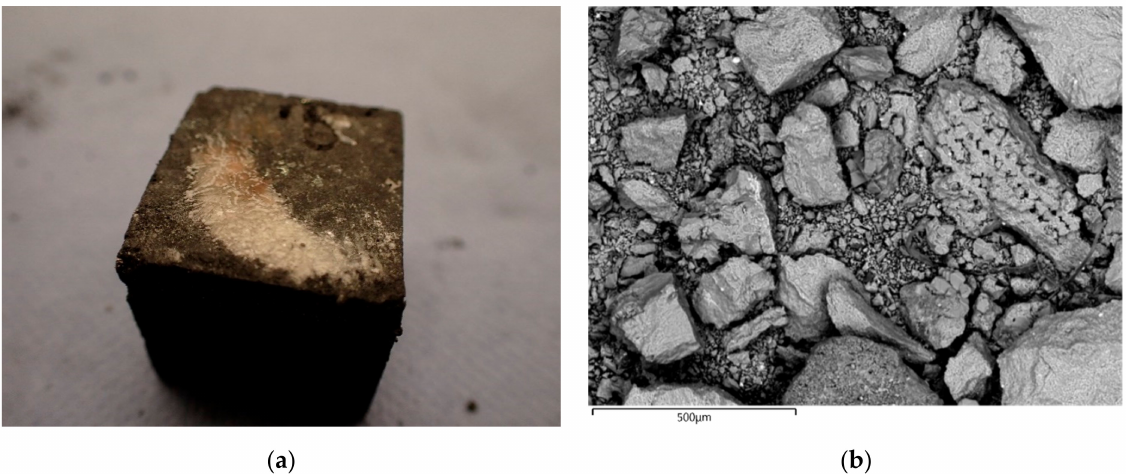
Figure 5. ( a ) Thin, layered slag deposition on a graphite cube from the experiment NMC622. ( b ) SEM image of the slag phase from NMC622 under 100-fold zoom.